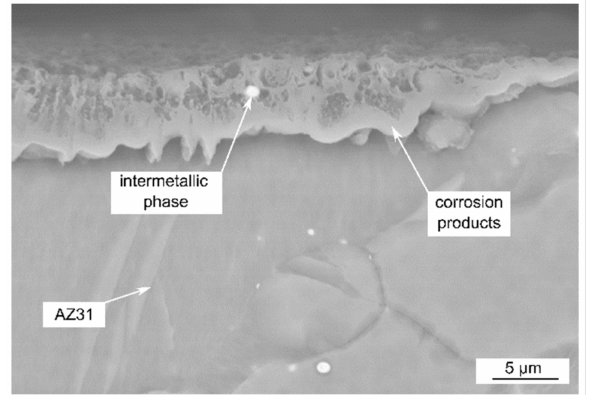
Figure 10. Cross-section of the untreated specimen after immersion in SBF solution for 168 h,